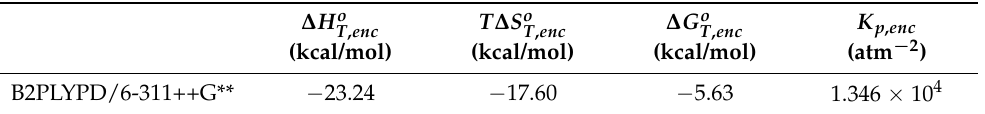
Figure A1. Two views of the M06-2X/6-31++G** optimized structure of H 2 O · HF@C 70 . Table A2. The standard a enthalpy ∆ H o equilibrium constants K p , enc for the gas-phase equilibrium formation (1) of H 2 O · HF@C 70 , evaluated b at room temperature T = 298.15 K.